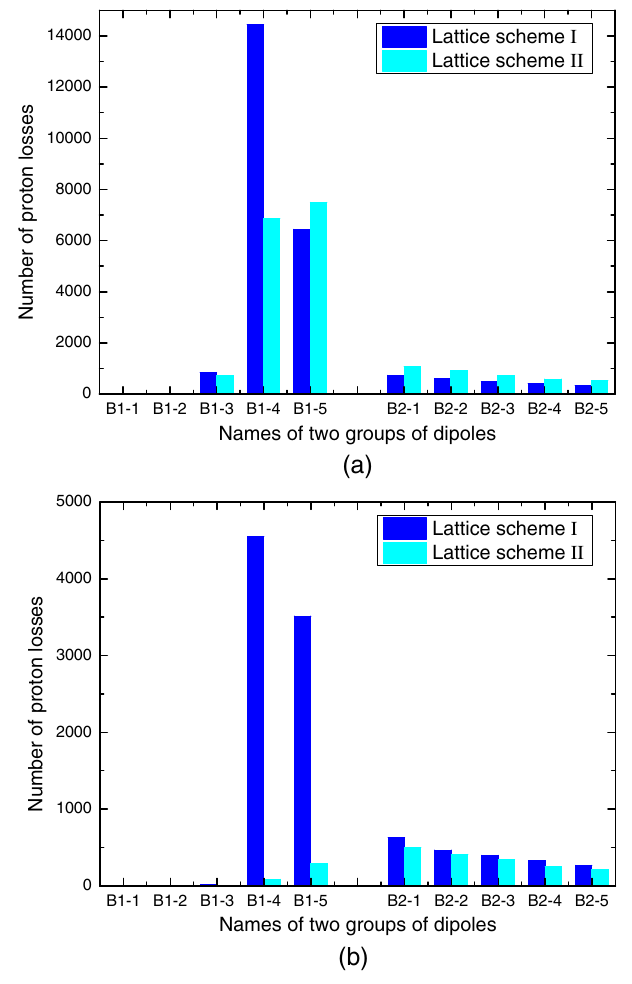
FIG. 9. Proton losses in the first and second groups of dipoles with two lattice schemes, with an initial horizontal (a) or vertical (b) halo distribution. The total particles in the simulations are 100